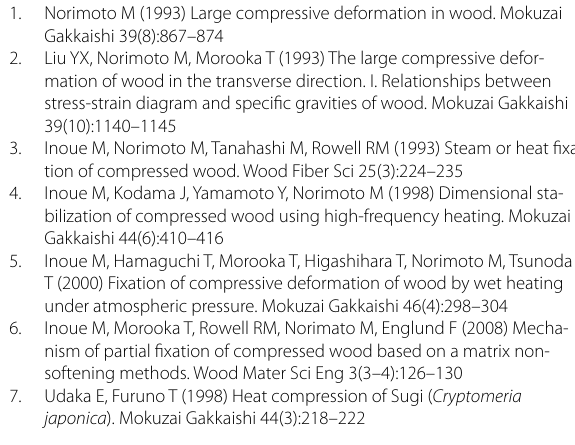
used wood or average density of the sandwich compressed wood. However, compressed wood with high compression percent display high surface hardness.